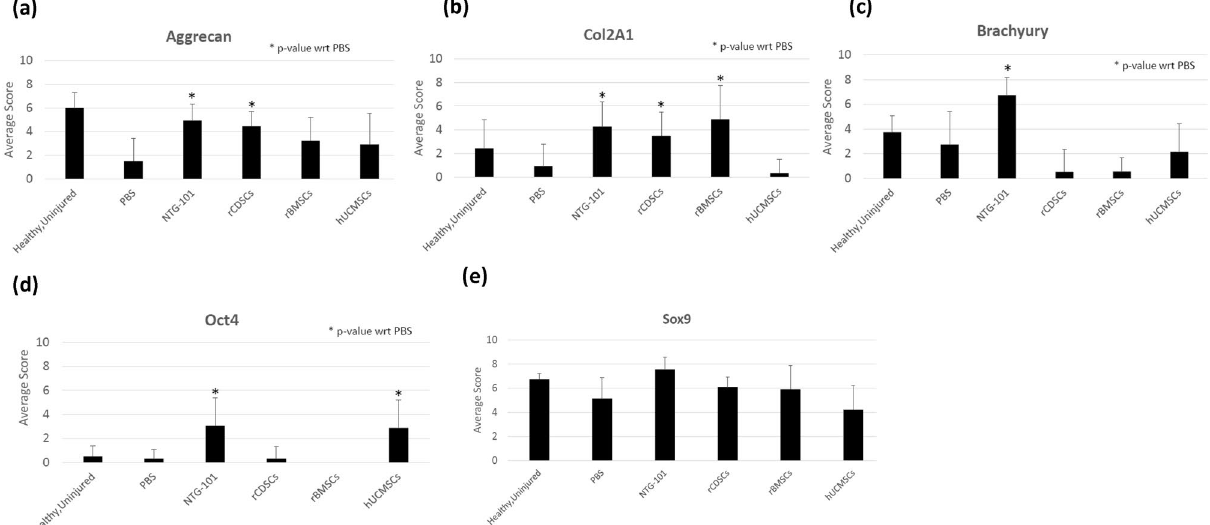
Figure 5. Panel shows the histograms representing average total score of immunohistochemical analysis of ( a ) Aggrecan, ( b ) Collagen 2A1, ( c ) Brachyury, ( d ) Oct4 and ( e ) Sox9 in rat IVD-NP tissue sections of healthy, and injured IVDs injected with PBS, NTG-101, rCDSCs, rBMSCs or hUCMSCs (*p ≤